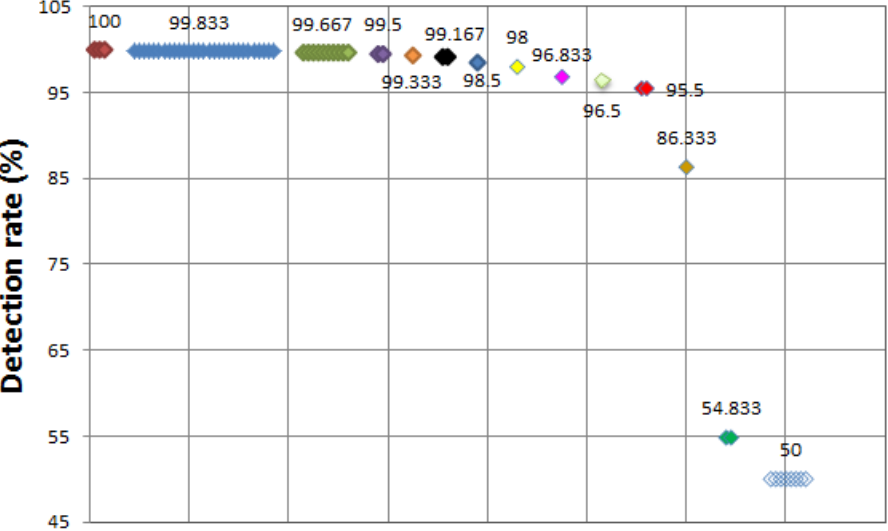
Figure 7. SYN flood attack—detection rate (after